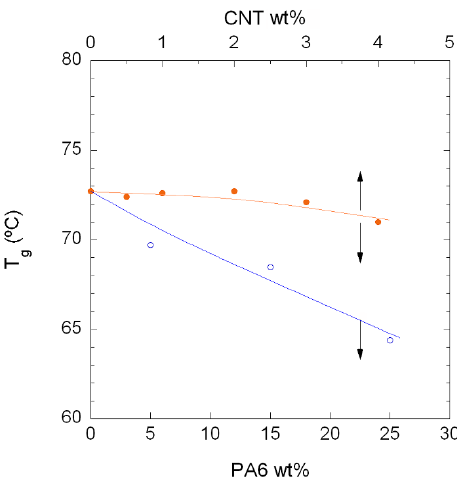
Figure 6. Glass transition temperature ( T g ) of the unfilled PA410/PA6 blends ( ○ ) and PA410/PA6/CNT NCs (●) vs. CNT and PA6 content.